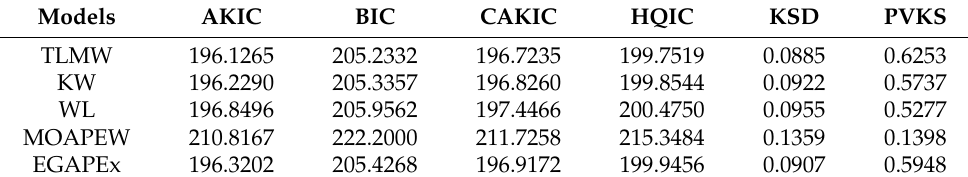
Table 11. Discrimination criteria and KS test of the TLMW model parameters for Guinea Pigs data.